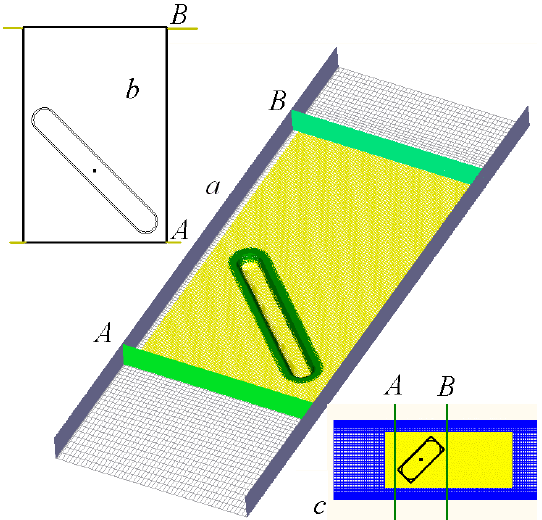
Figure 3. Multiblock grid for a narrow channel with an oval-trench dimple covered with a